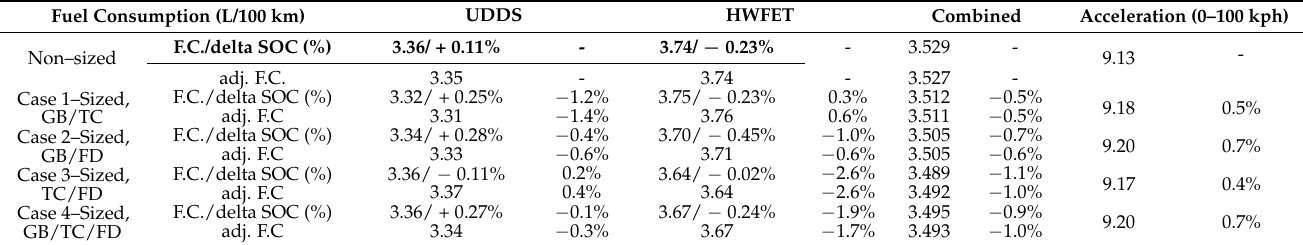
Table 4. Fuel consumption and acceleration time results for UDDS and HWFET and combined.